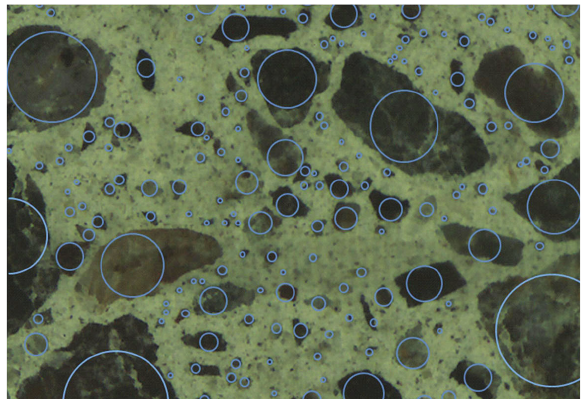
Fig. 8. Comparison between spherical approximation and